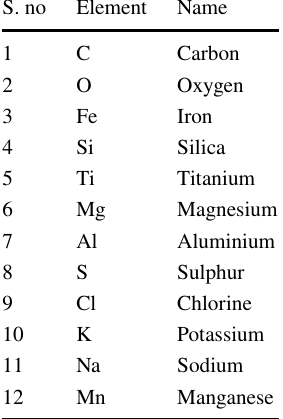
Fig. 2 EDX results at different angles of exposure Table 2 EDX identified elements of the core